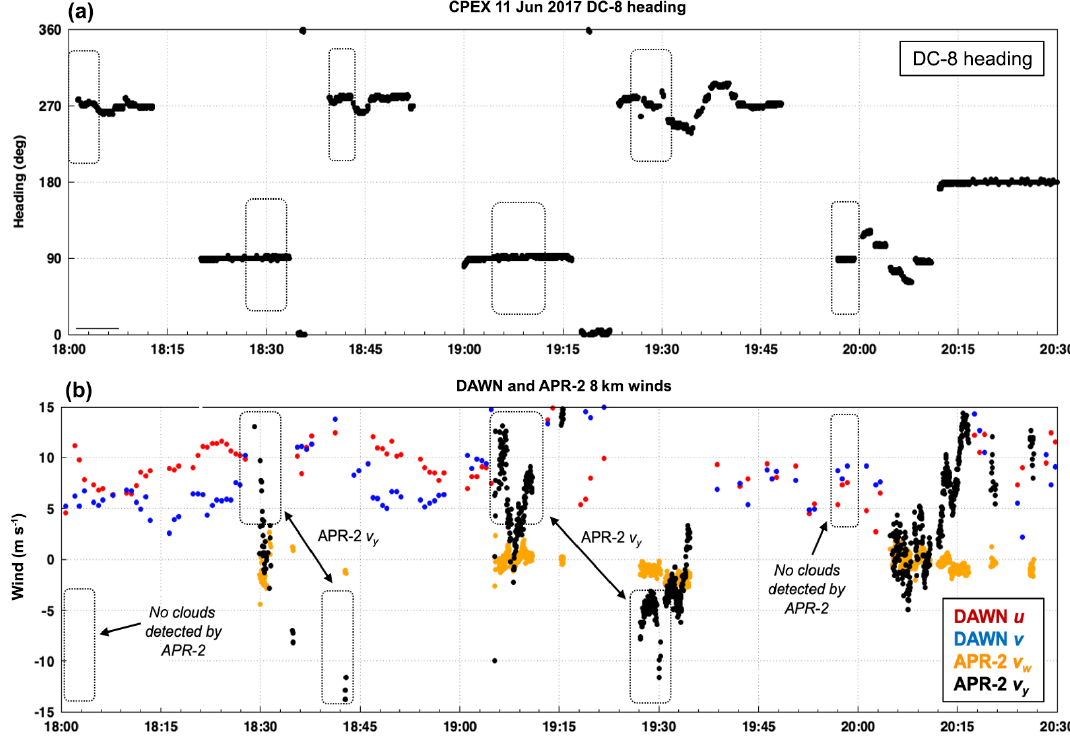
Figure 20. (a) DC-8 heading between 18:00 and 21:30UTC on 11 June 2017, highlighting the six time periods depicted in Fig. 19. (b) DAWN ( u,v ) wind vectors at the 8km level (red and blue points, respectively). APR-2 ( v w ,v y ) winds (orange and black, respectively) estimated from Eqs. (3) and